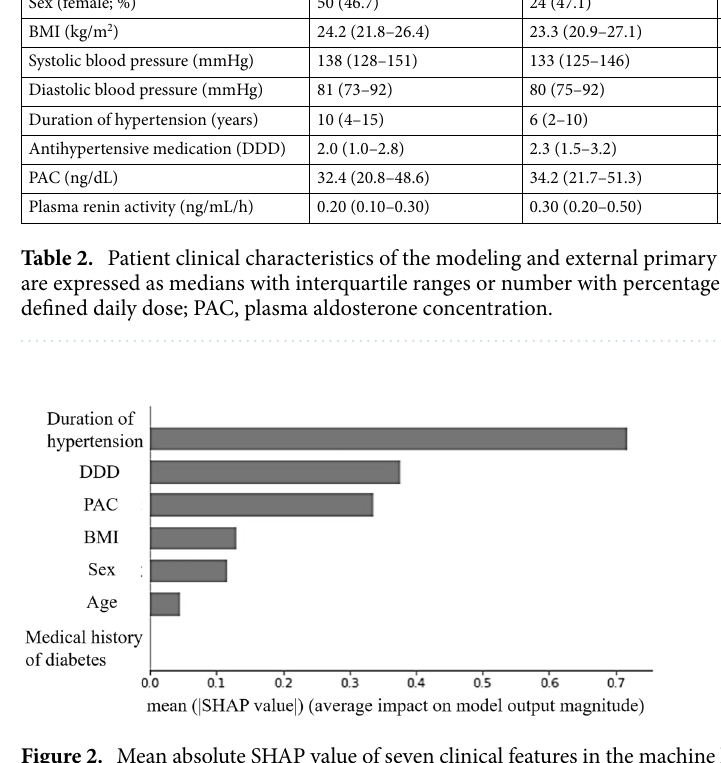
Figure 2. Mean absolute SHAP value of seven clinical features in the machine learning-based predictive model for complete clinical